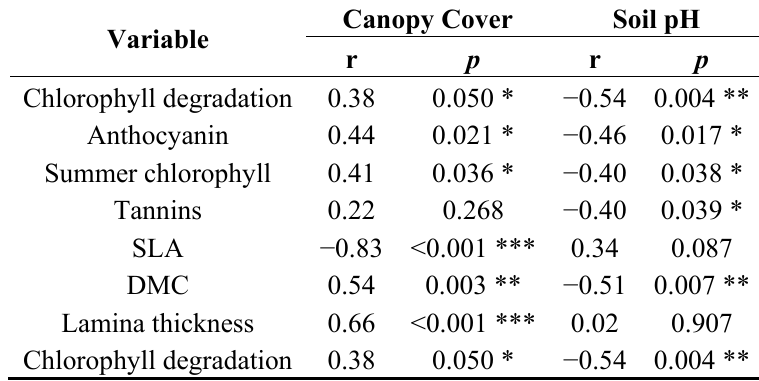
Table 1. Correlations of the leaf variables chlorophyll degradation by September, anthocyanin content in autumn, summer chlorophyll content, tannin content, SLA, dry matter content and lamina thickness with the measured environmental factors being canopy openness and soil pH ( n =